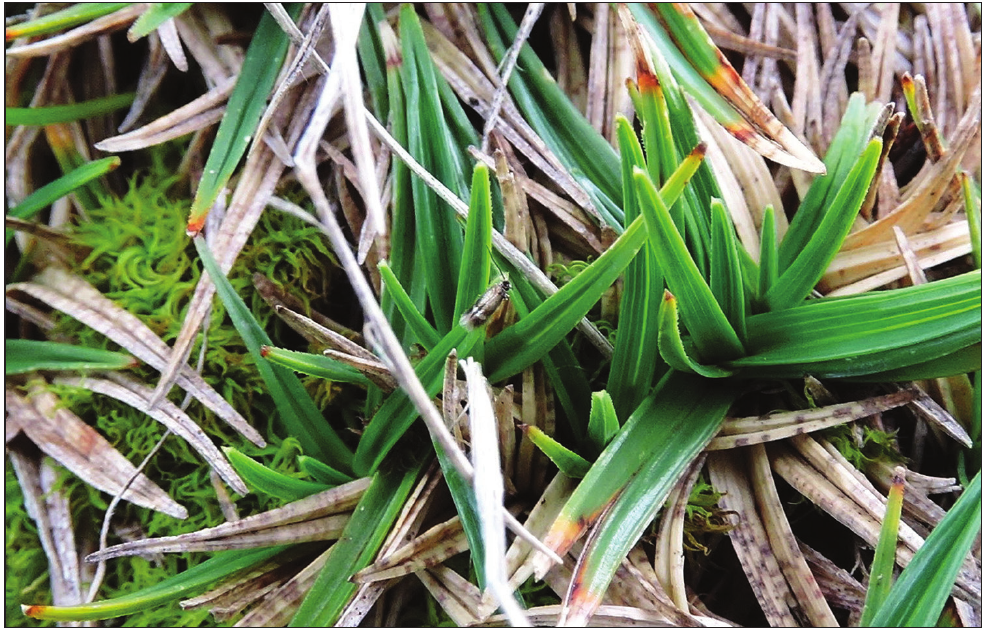
Figure 9. The Belianske Tatra Mts, Zadné Jatky Mt., 30.vii.2016, adult of Stigmella tatrica sitting on Carex firma. Photograph F.